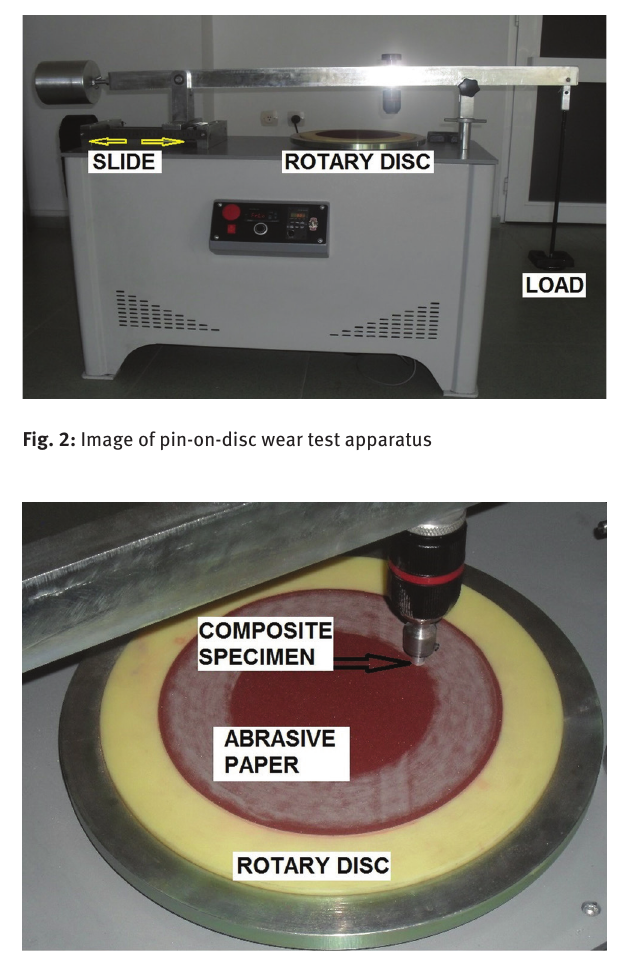
Fig. 3: A scene from the abrasive wear test